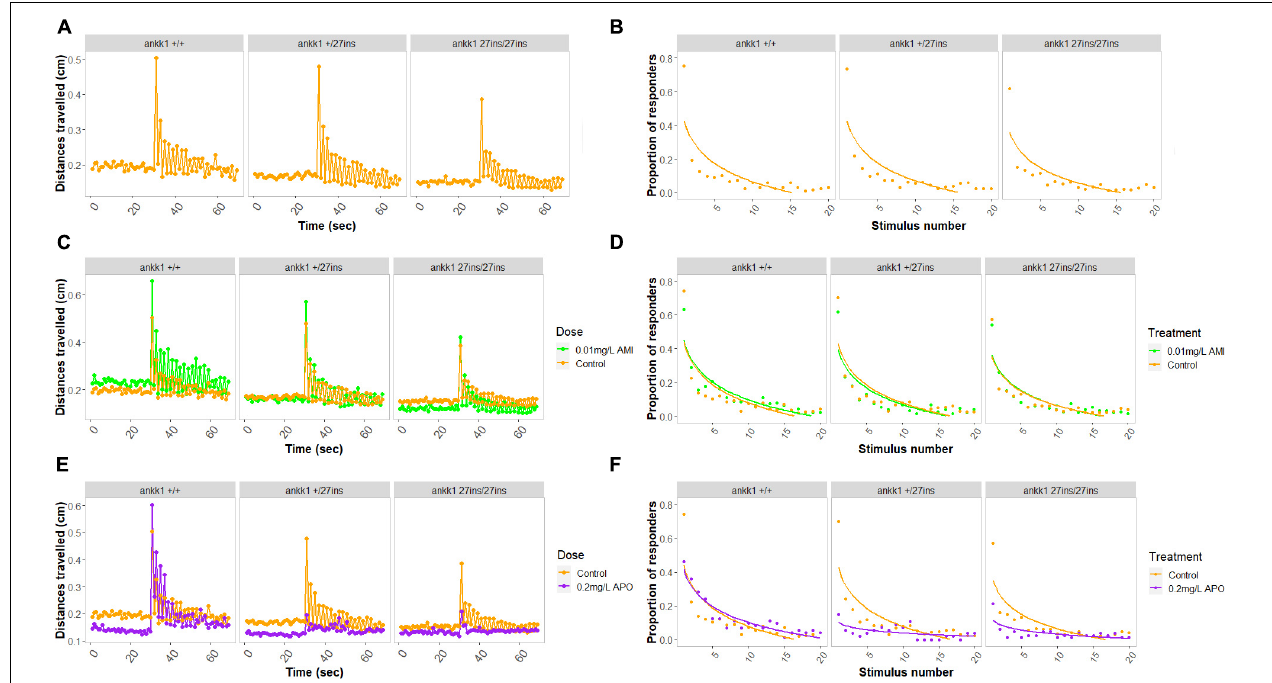
FIGURE 8 | Habituation to acoustic startle response in 5 days post fertilization larvae ( ankk1 + / + , ankk1 + / 27 ins , and ankk1 27 ins / 27 ins ) in presence (0.01 mg/L) or absence (control) of amisulpride. The assay consisted of 60 s of basal tracking, followed by 20 acoustic stimuli within 2 s intervals. (A,C,E) Mean distances traveled by ankk1 + / + , ankk1 + / 27 ins , ankk1 27 ins / 27 ins . Sample size: N = 145 per genotype. (B,D,F) Proportion of individuals responding to each startle stimulus. N = 226 ankk1 + / + control , N = ankk1 + / 27 ins control , N = 226 ankk1 27 ins / 27 ins control , N = 226 ankk1 + / + AMI , N = 145 ankk1 + / 27 ins AMI , N = 145 ankk1 27 ins / 27 ins AMI , N = 145 ankk1 + / + APO , N = 145 ankk1 + / 27 ins APO , N = 145 ankk1 27 ins / 27 ins APO . Error bars show standard error of the